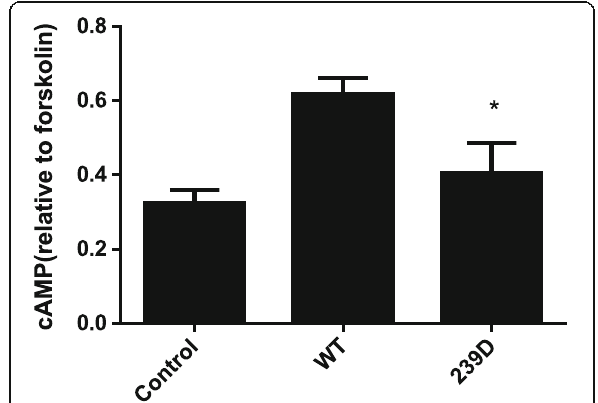
Fig. 3 In vitro cAMP production by OK cells transfected with Gs α - wild-type (WT) or Gs α -239D (N239D, mutant). Cells transfected with the empty plasmid vector were used as controls. Compared with that in cells transfected with the WT, the PTH-induced cAMP production was significantly decreased in the Gs α -239D group when normalized to forskolin-stimulated cAMP levels. * P < 0.01